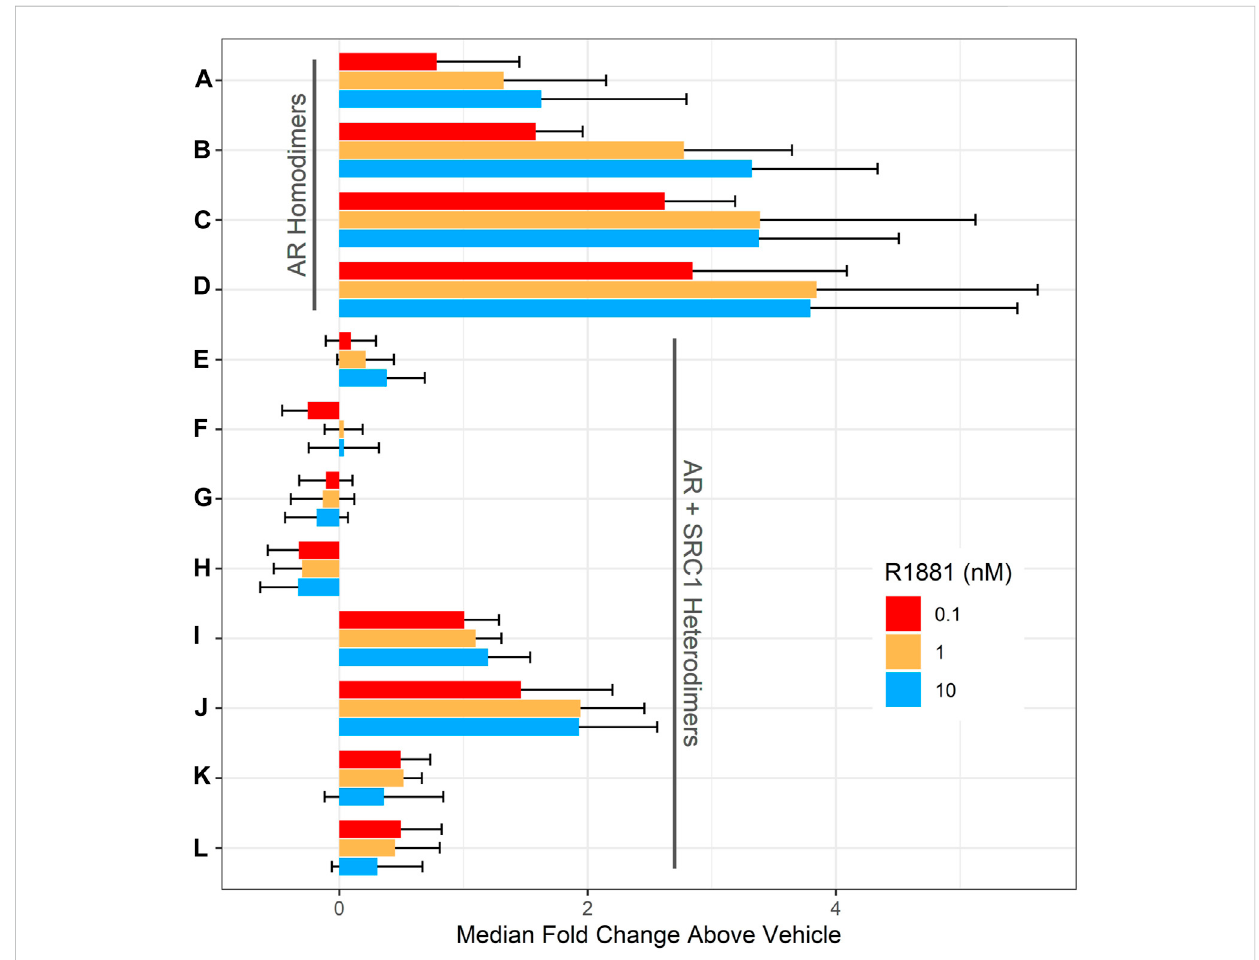
FIGURE 1 Evaluation of AR dimer pairs. HepG2 cells were transiently transfected with DNA plasmids encoding one LgBit and one SmBit fusion. The LgBit and SmBit fusion parter pairings (A – L) are listed in Table 1. 56 h after transfection, cells were treated with R1881 at 0.1 (red), 1 (orange), or 10 nM (blue; fi nal concentration) for 18 h before NanoLuc luciferase activity was detected. Data are expressed as median fold change over DMSO-treated (vehicle) wells ± the median absolute deviation (mad) and represent four replicate wells for each group at each concentration tested in three independent